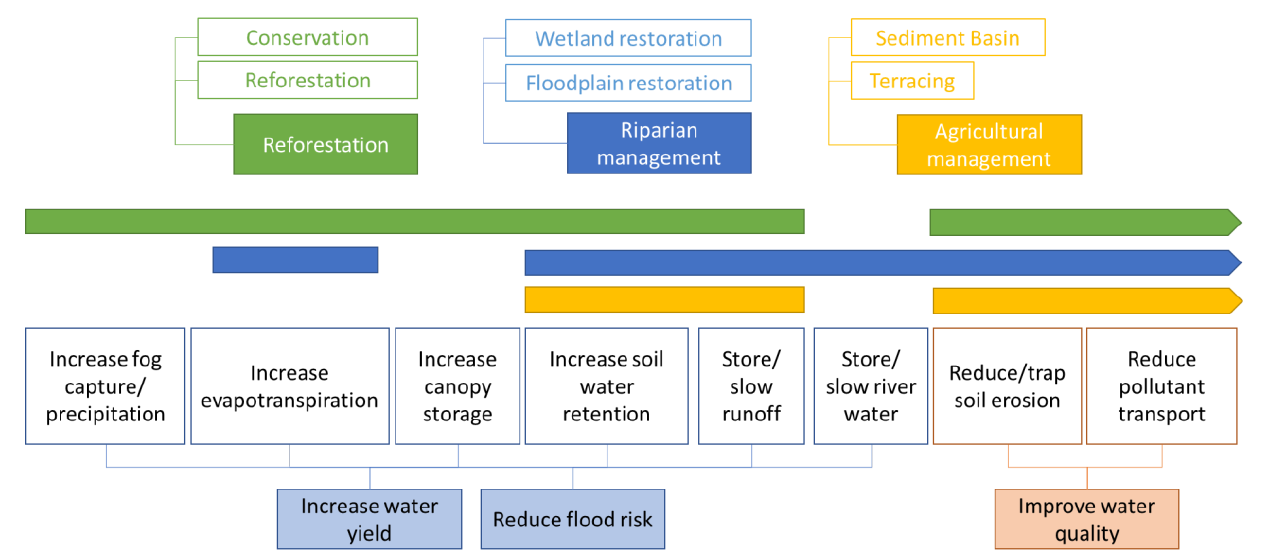
Figure 4. Conservation actions’ impact on water quantity and quality of a watershed.